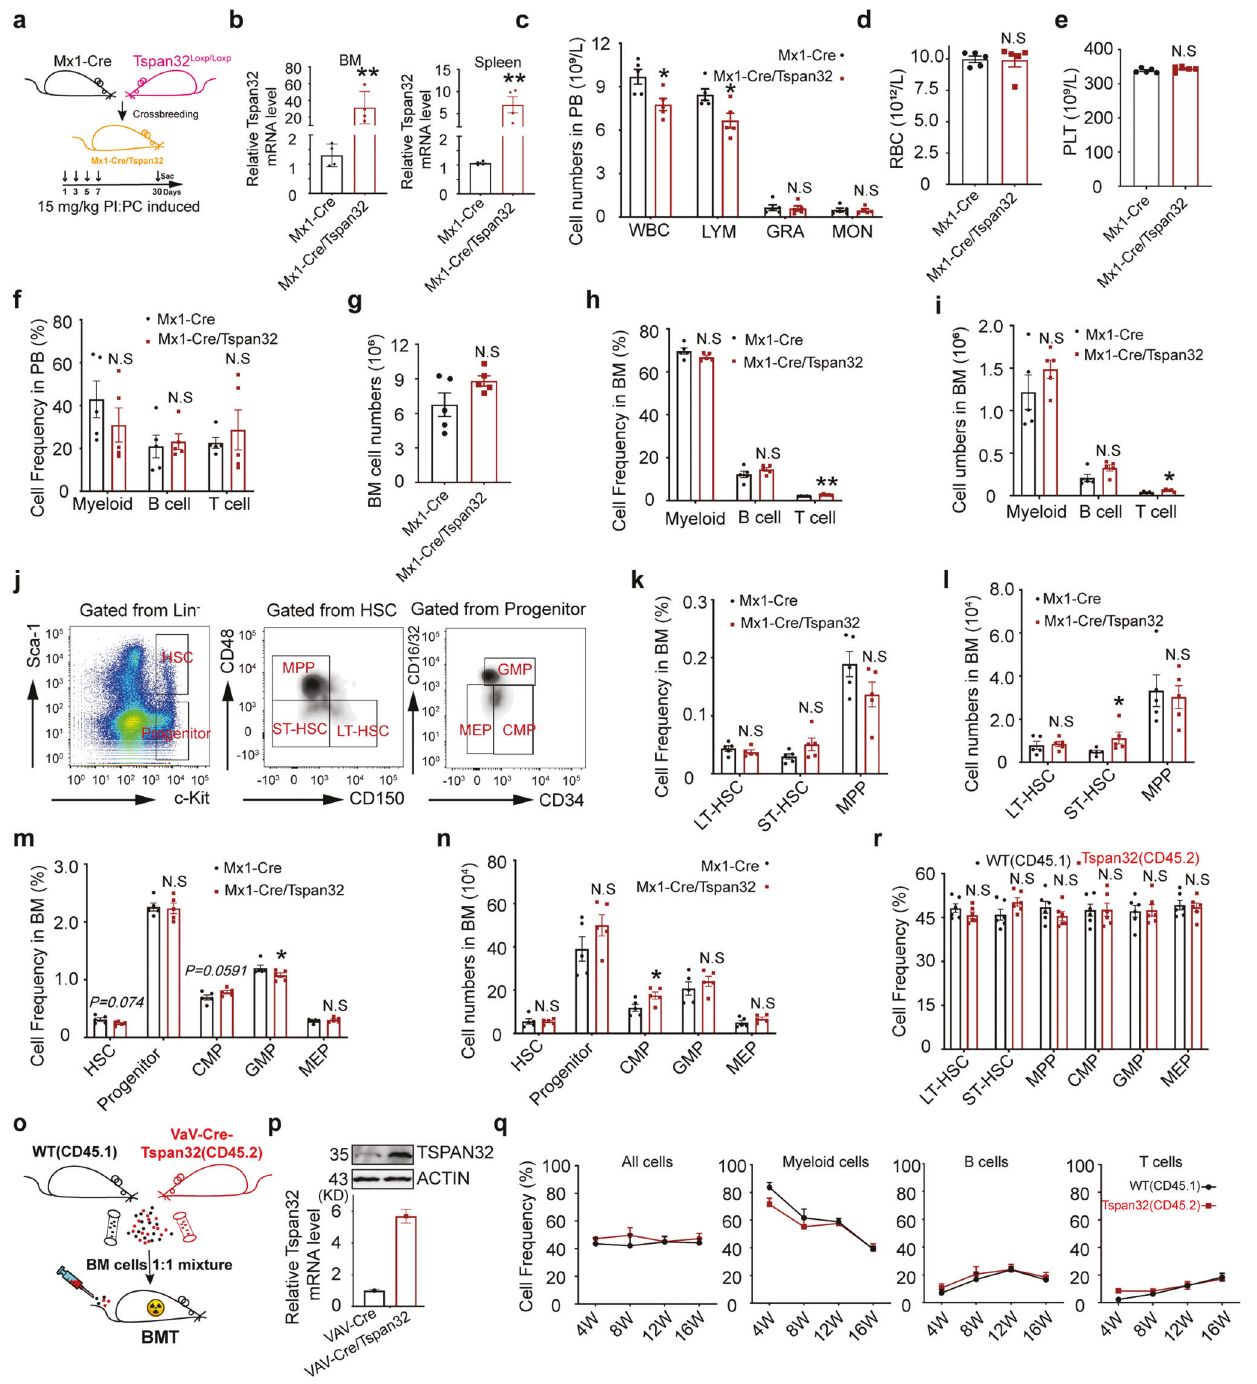
Fig. 5 The effect of Tspan32 overexpression on the hematopoietic system in normal mice. a , b Mx1-Cre/Tsp-KI mice were treated four times with 15 mg/kg Pipc every other day. Tspan32 expression in cells from BM and spleen were analyzed with RT-PCR on day seven. Hematopoiesis and HSCs were analyzed on day 30 post Pipc induction ( n = 5 per group). c – e Blood cell counts in the PB. f The percentage of lineage cells including myeloid cells (Gr-1), B cells and T cells in PB. g Total cell number counts in BM. ( h-i ) The percentage and number of lineage cells including myeloid cells (Gr-1), B cells and T cells in BM. j Analysis for HSC (LT-HSC, ST-HSC, MPP) and progenitors (CMP, GMP, MEP) according to cell surface markers. k , l The percentage and number of LT-HSC, ST-HSC and MPP in BM. m , n The percentage and number of HSCs and progenitors including CMP, GMP and MEP in BM. o , p Vav-Cre/Tsp-KI mice (CD45.2) mixture with CD45.1 BM cells at a 1:1 ratio for a competitive repopulation assay, RT-PCR and immunoblotting analysis for Tspan32 expression in cells from BM. q The percentage of replenished lineage cells in PB for recipients receiving an equal mix of BM cells with high Tspan32 expression (Cd45.2) and WT (Cd45.1) BM cells at weeks 4, 8, 12, and 16 post BMT. r The percentage of replenished HSCs (LT-HSC, ST-HSC, MPP) and progenitors (CMP, GMP, MEP) in the BM of recipients at week 16. Error bars denote mean ± SEM, N.S, no signi fi cance, * P < 0.05, ** P < 0.01 ( T -test)